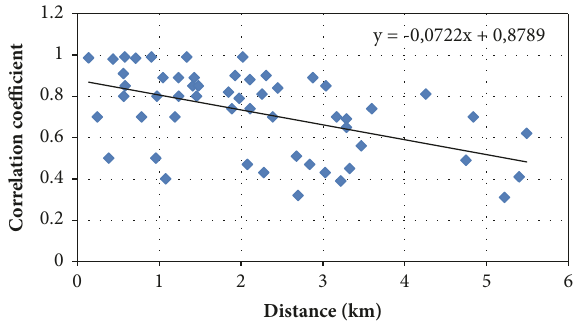
Figure 3: Spatial-correlation